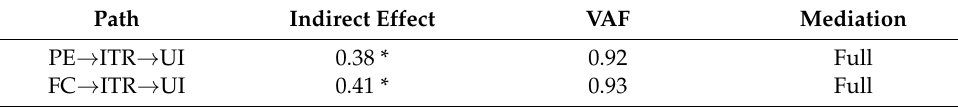
Table 4. Mediation result.